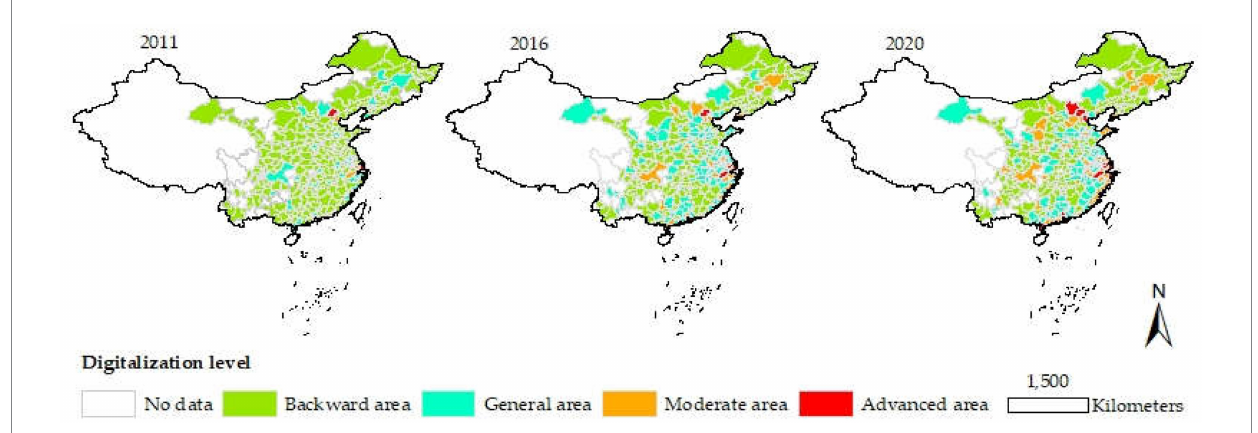
FIGURE 1 The spatiotemporal evolution of digitalization development in China’s cities. This map is based on the standard map of the Map Technical Review Center of the Ministry of Natural Resources [review number GS (2020) No. 4618], and the base map has not been modified.